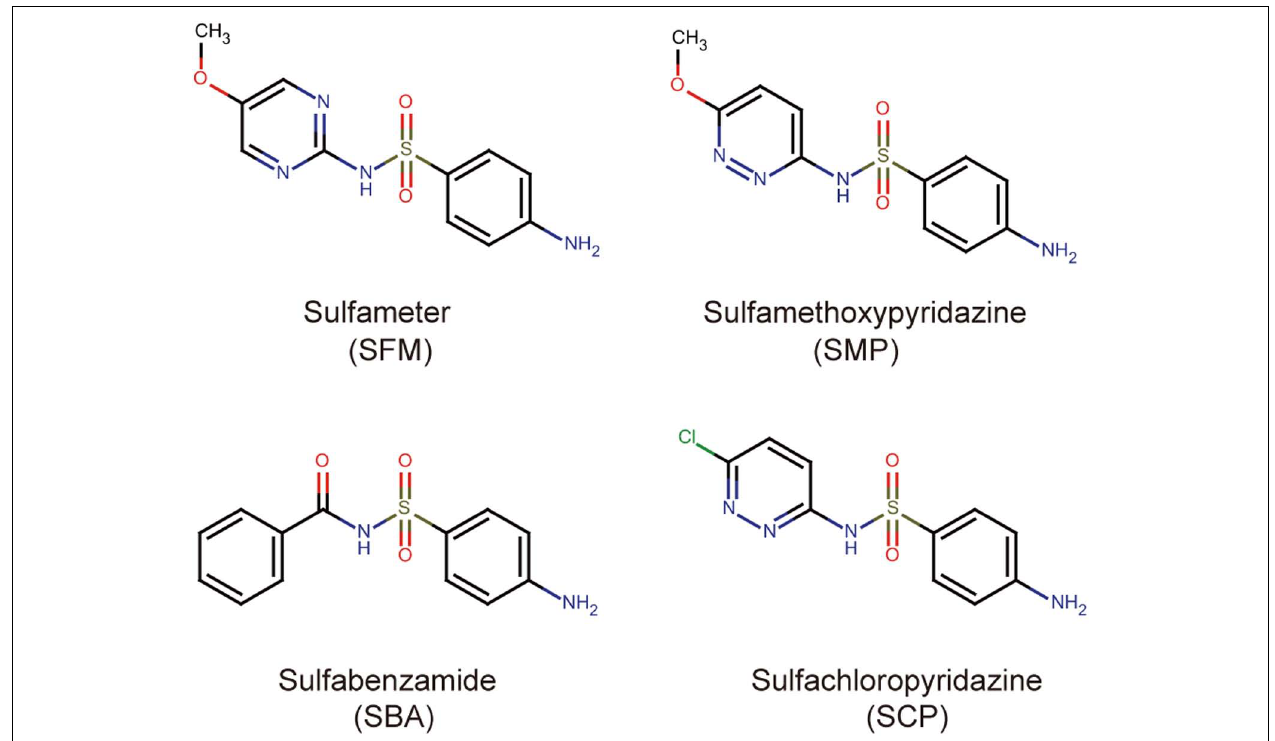
FIGURE 1 | Chemical structures of the sulfonamide compounds isolated from the chemical screening.